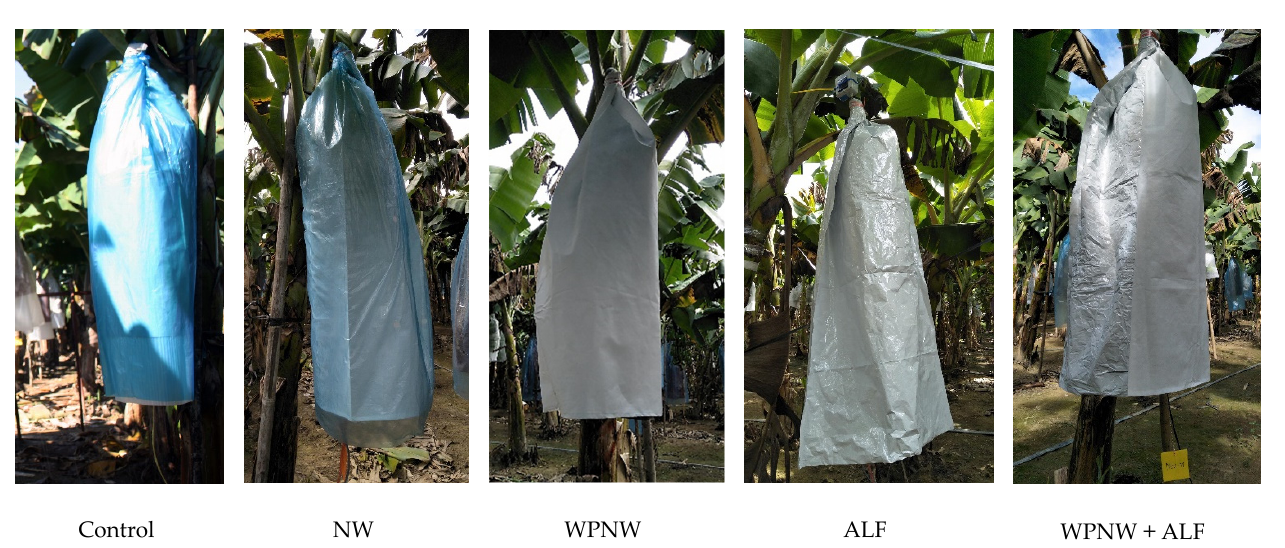
Figure 1. Five treatments of banana bunch